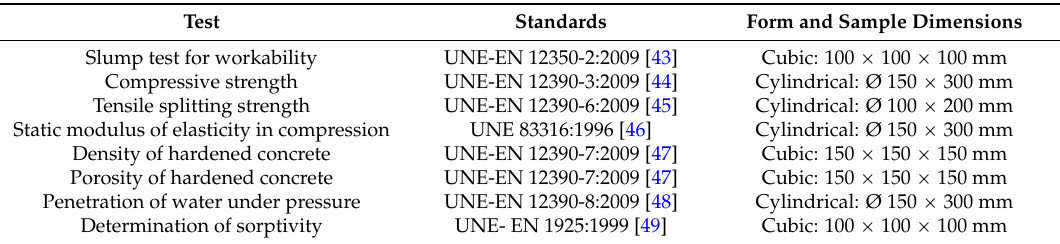
Table 6. Tests performed to study the properties of concrete.